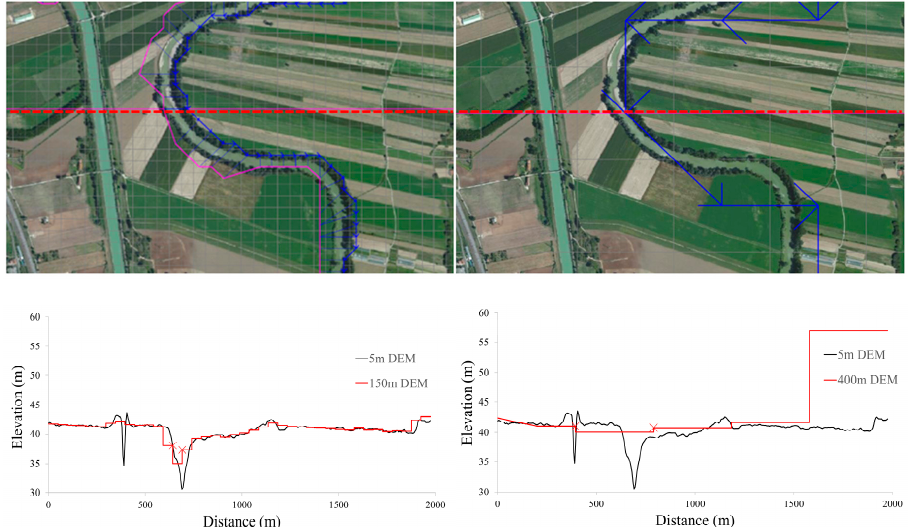
Figure 2. The impact of varying resolution represented by floodplain topographic plan view and cross sections. The 5 m floodplain terrain model is compared to interpolated 150 m ( left ) and 400 m ( right ) resolution DTMs. The upper and bottom plots show, respectively, the horizontal and vertical displacement of the interpolated floodplain grid schematization and cross section as respect to the high resolution